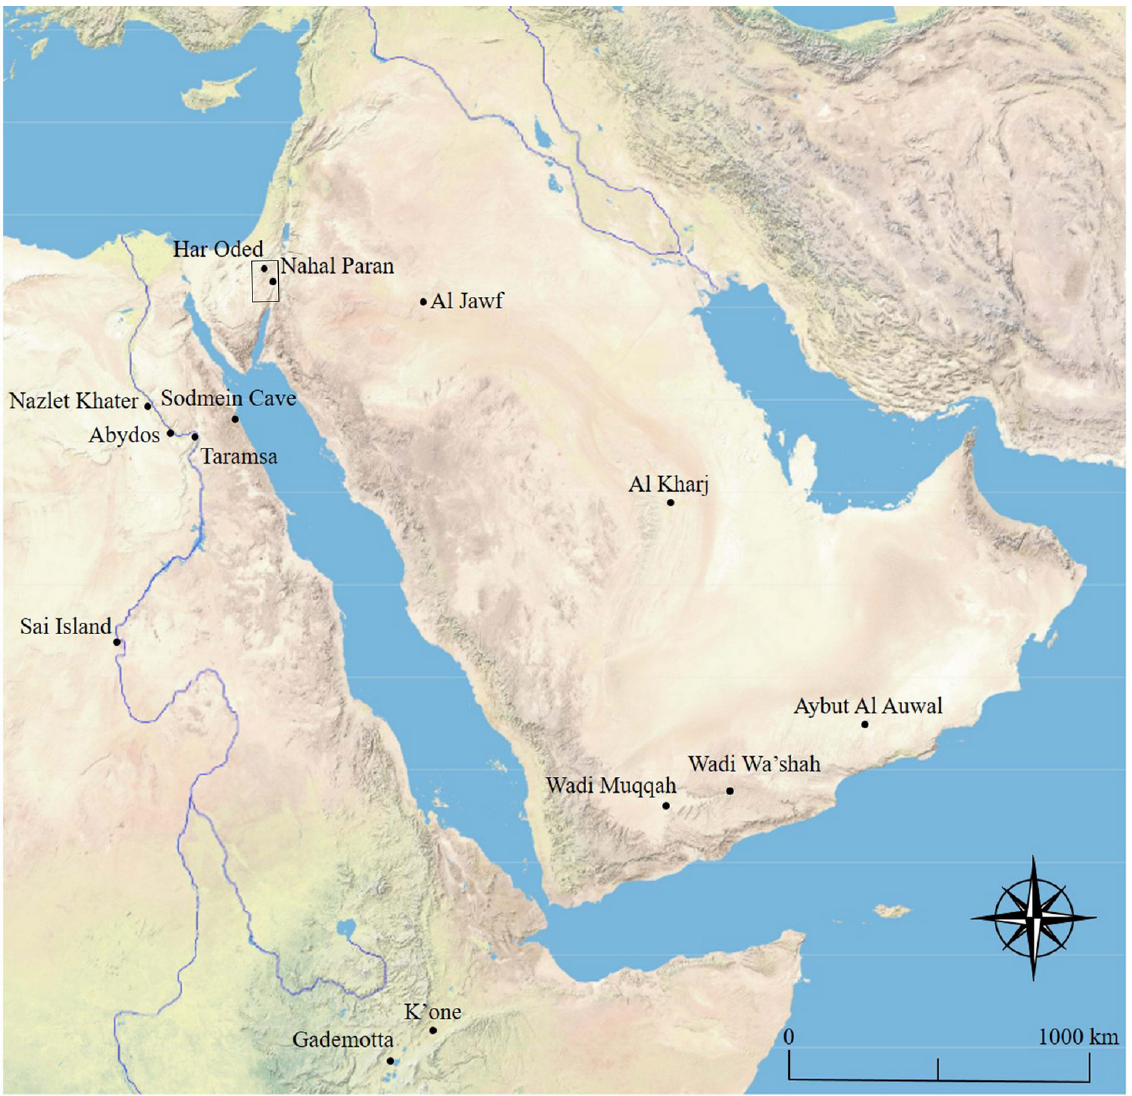
Figure 1. Regional map, noted are Middle Paleolithic sites with Nubian technology, the research area is marked by the black